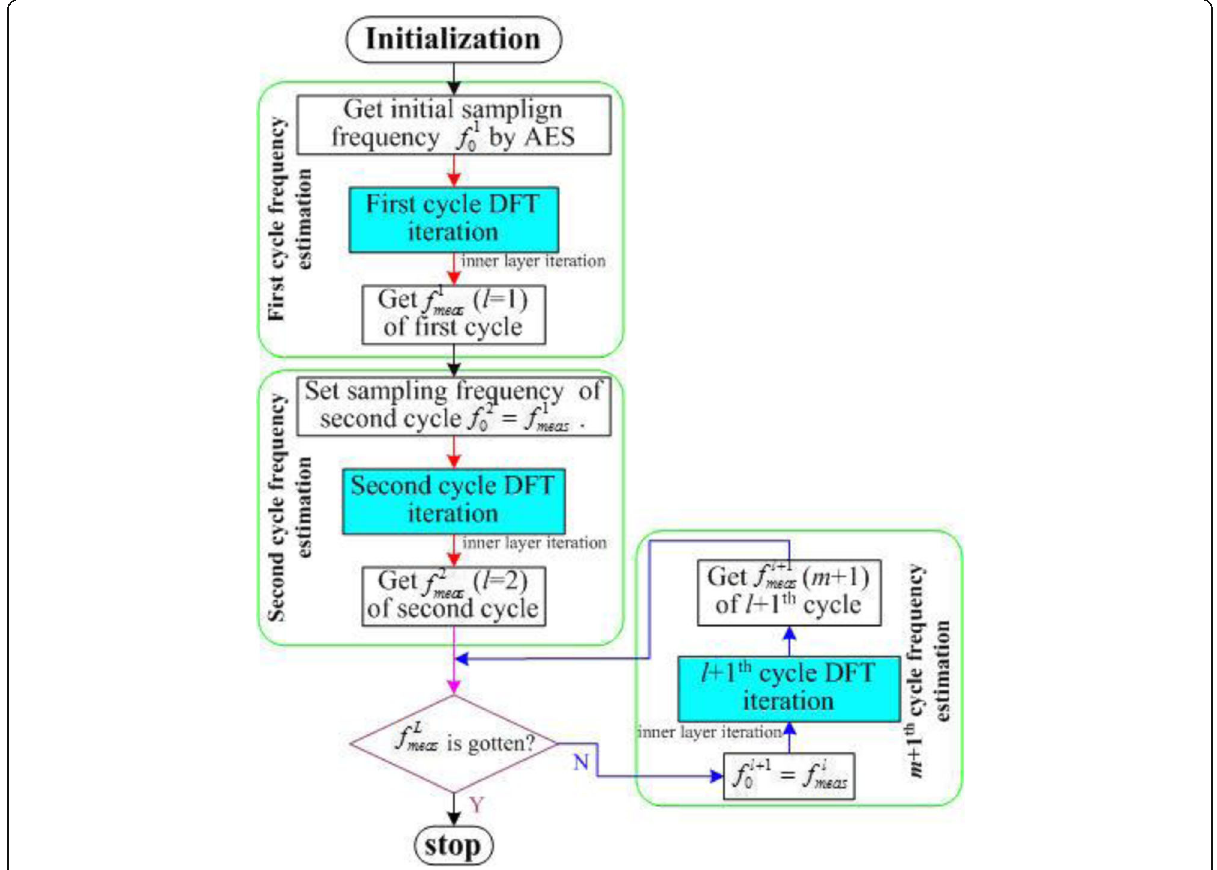
Fig. 5 Iteration process of TLI-DFT aided by